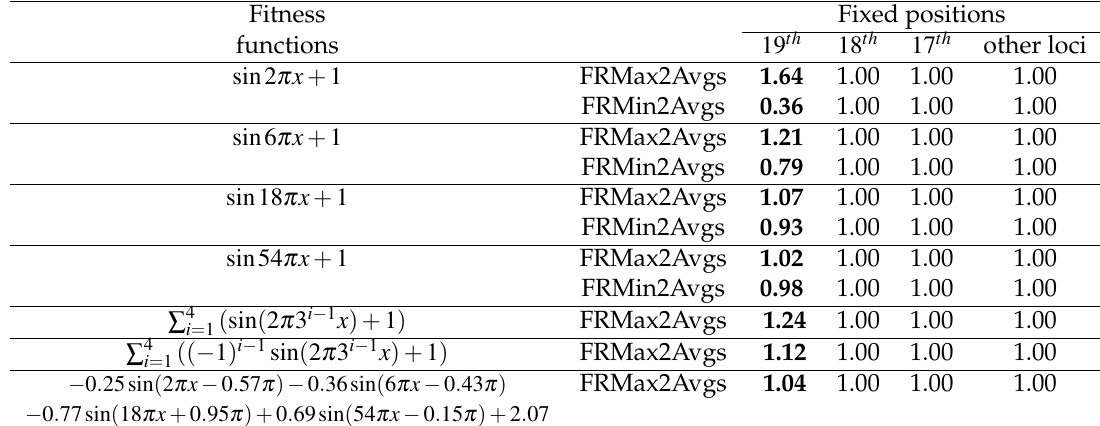
Table 4. The FRMax2Avgs and FRMin2Avgs for sin ( 2 π 3 i − 1 x )+ 1 , i ∈ { 1 , ··· , 4 } and the FR- Max2Avgs for some of their combinations under the base-2 encoding of string length